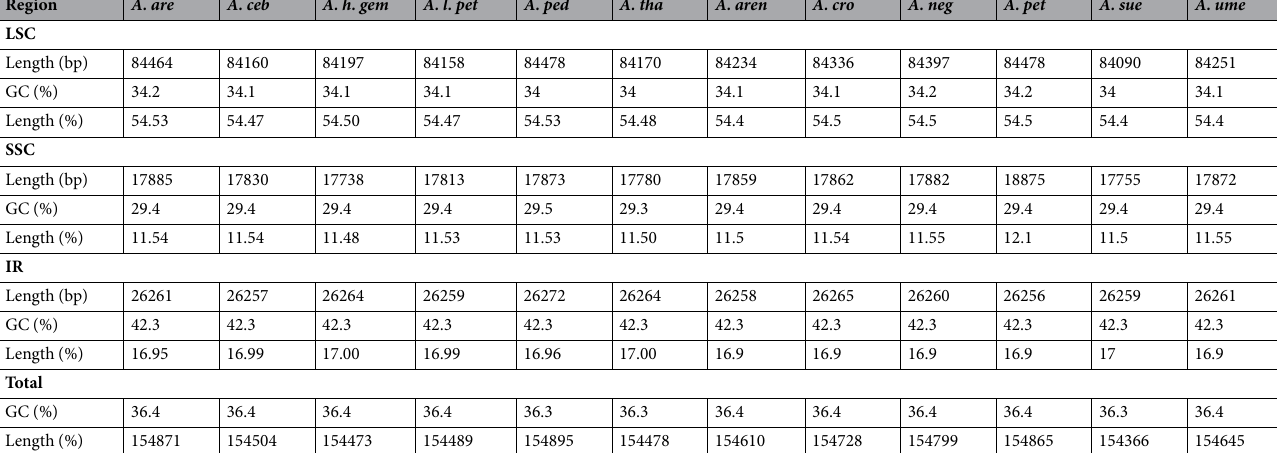
Table 1. Summary of complete chloroplast genomes for twelve Arabidopsis species. A. are = A . arenosa ;